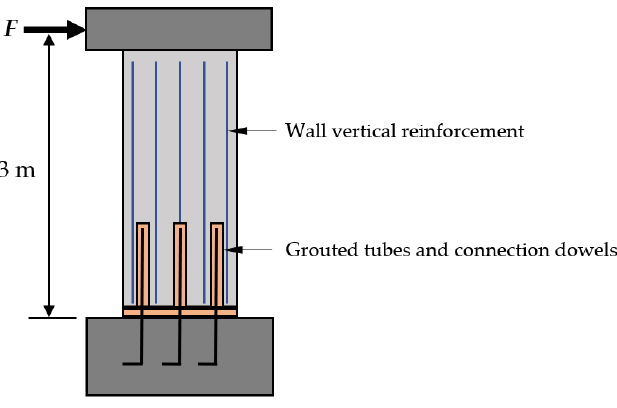
Figure 5. Illustration of SW1 and SW4 [14]. Table 1. Summary of two precast wall units SW1 and SW4 [14].